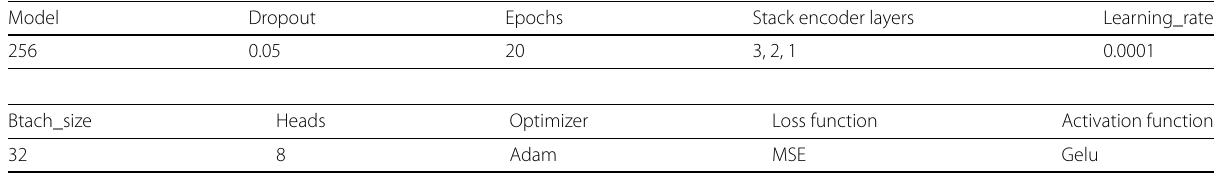
Table 1 Hyperparameters of models. Models: Informer and Enhanced Informer